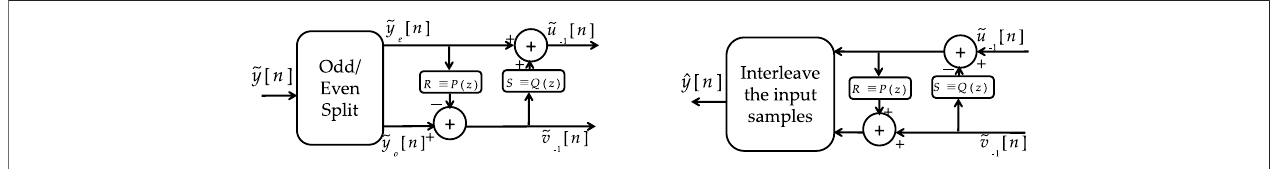
FIGURE 4 | Steps of lifting: split, predict, and update. (A) Wavelet decomposition; (B) wavelet reconstruction as proposed in Ansari and Gupta